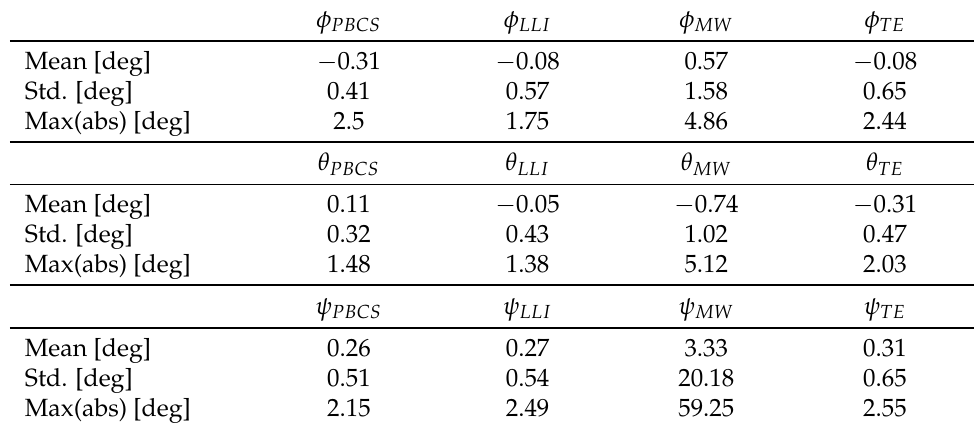
Table 13. Attitude angle difference statistics from KVH unit—Case Study